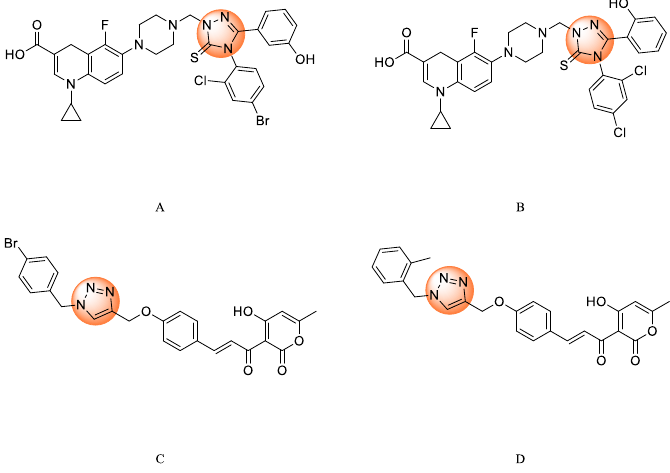
Figure 1. Recently discovered triazole derivatives as DNA topoisomerase inhibitors.